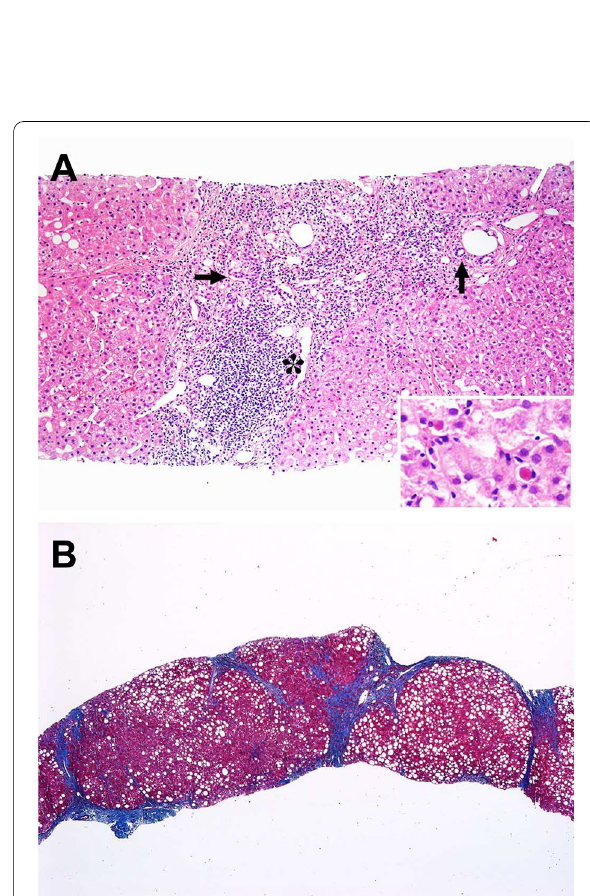
Fig. 4 A The portal tract shows nodular lymphoid aggregate (asterisk) in this case of recurrent Hepatitis C with more than mild lymphocytic inflammation. The bile ducts (arrows) are intact, H&E stain (inset) shows lobular necroinflammatory activity. B A case with cirrhosis, trichrome